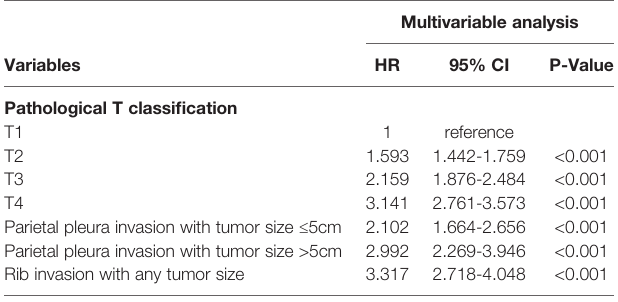
TABLE 3 | Multivariable Cox regression analysis for cancer-speci fi c mortality in patients with different pathological T classi fi cations.